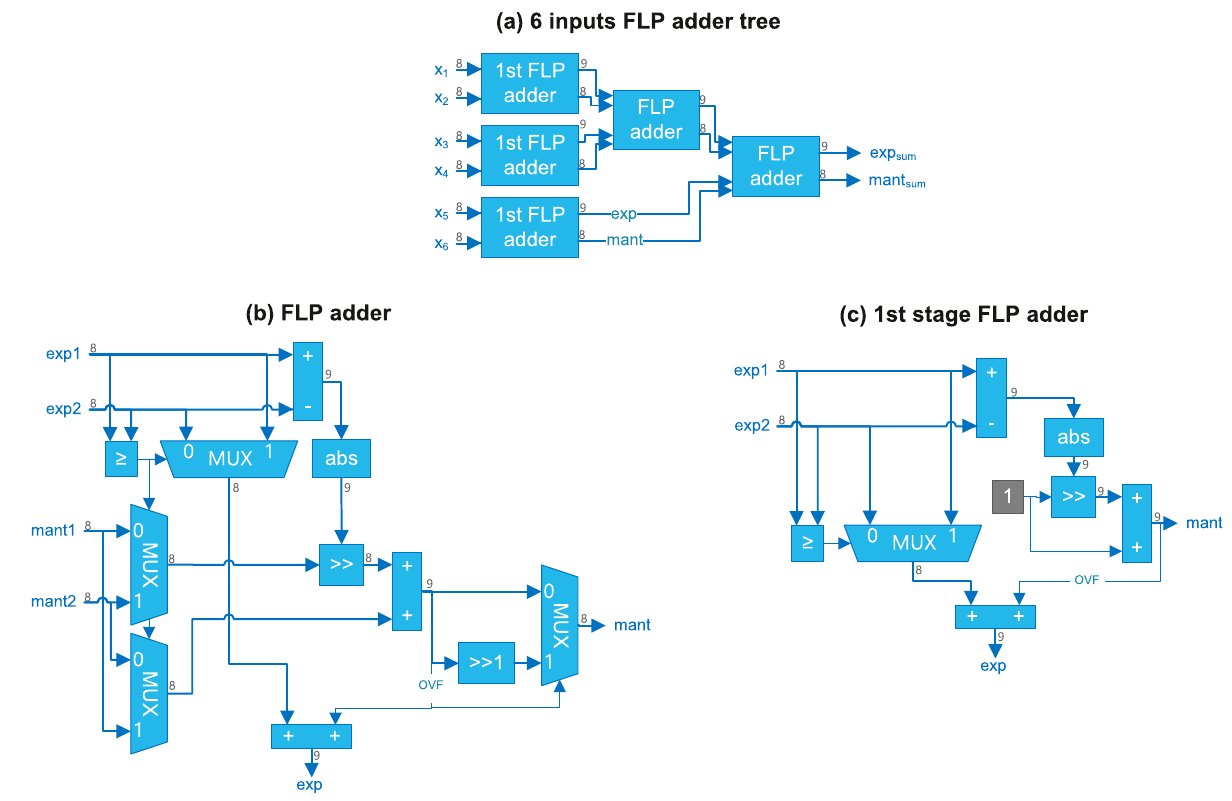
Figure 3. ( a ) Example of 6 8-bit inputs FLP adder tree. ( b ) Architecture of a FLP adder. ( c ) Architecture of the optimized FLP adder used in the first level of the